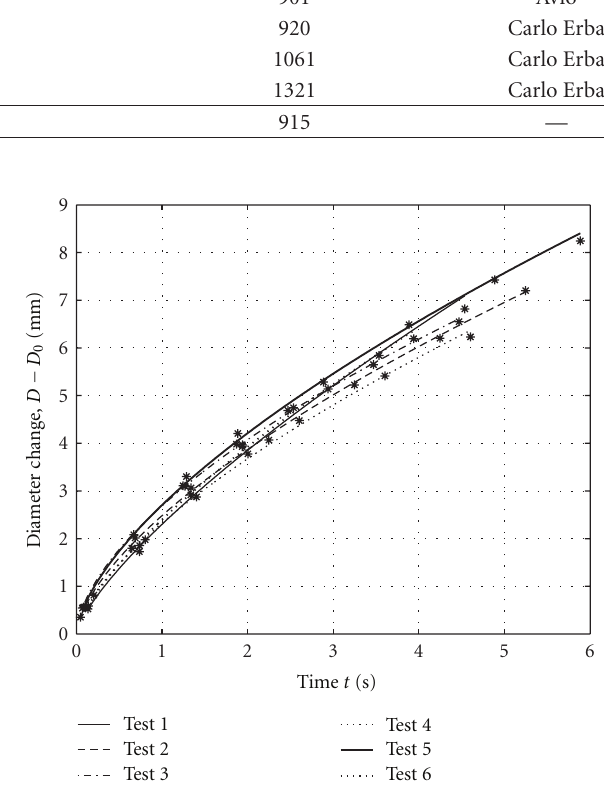
Figure 3: HTPB baseline: ignition delay. Experimental data and purely convective model by Ohlemiller and Summerfield [19], for two di ff erent final surface temperatures [25, 26].